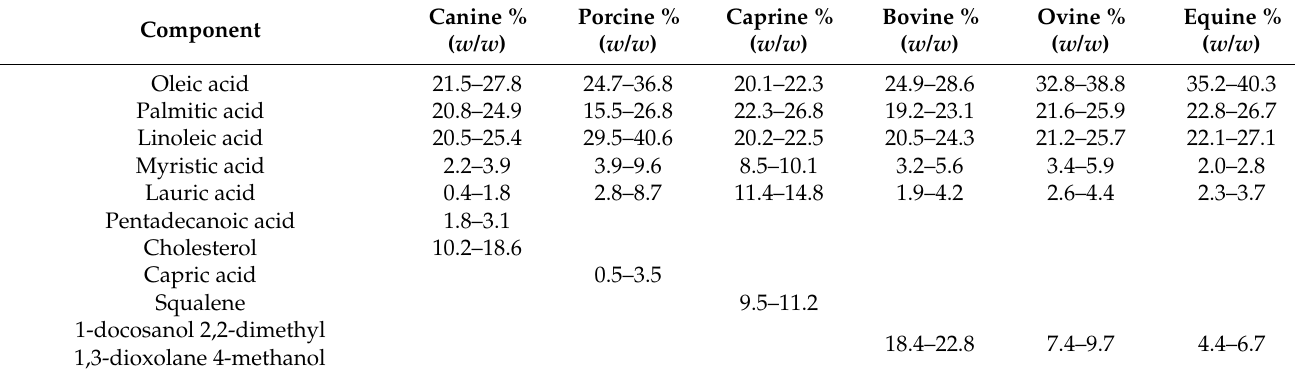
Table 2. Comparison of different fatty acid ratios that constitute the appeasing pheromone identified for different mammals [199].